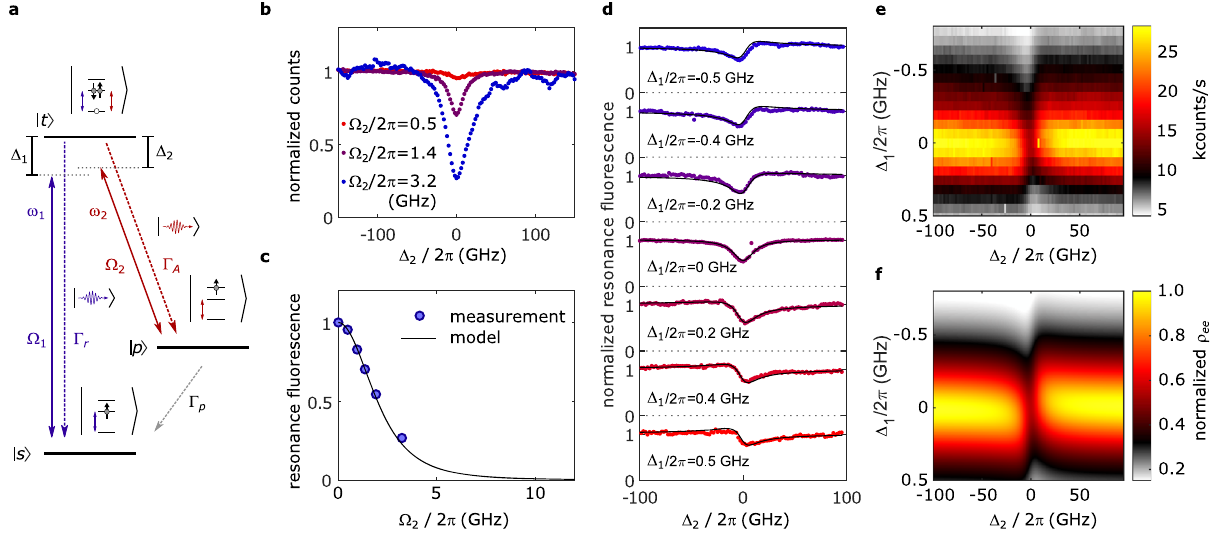
Fig. 3 Optically driving the radiative Auger transition. a The level scheme where one laser ( ω 1 ) with Rabi frequency Ω 1 drives the fundamental transition ( s j i – t j i ) while a second laser ( ω 2 ) drives the radiative Auger transition ( p j i – t j i ) with Rabi frequency Ω 2 . b Resonance fl uorescence ( Ω 1 = 2 π × 0.08 GHz) as a function of detuning Δ 2 (detuning of ω 2 ). At low values of Ω 2 , the resonance fl uorescence intensity is almost constant for different values of Δ 2 . For the highest value of Ω 2 , the resonance fl uorescence drops by up to ~ 70% on bringing ω 2 into resonance with the radiative Auger transition. The strong fl uorescence dip at a particular frequency is a characteristic feature of a Λ -system driven with two lasers that are detuned in frequency by the ground state splitting. c Resonance fl uorescence at Δ 2 = 0 as a function of Ω 2 . The resonance fl uorescence intensity (blue dots) drops with increasing Ω 2 , fi tting well to the theoretical model (black line). d Fluorescence intensity as a function of detuning Δ 2 . The Rabi frequencies are Ω 1 = 2 π × 0.27 GHz, Ω 2 = 2 π × 2.1 GHz. The same measurement is repeated for a series of fi xed detunings Δ 1 (detuning of ω 1 from the fundamental transition). Detuning ω 1 leads to an asymmetric fl uorescence dip. This asymmetry is well captured by our quantum optics simulations (black lines) based on the level scheme shown in ( a ). e Fluorescence intensity as a function of laser detunings Δ 1 , Δ 2 . f Simulation of the fl uorescence intensity as a function of the laser